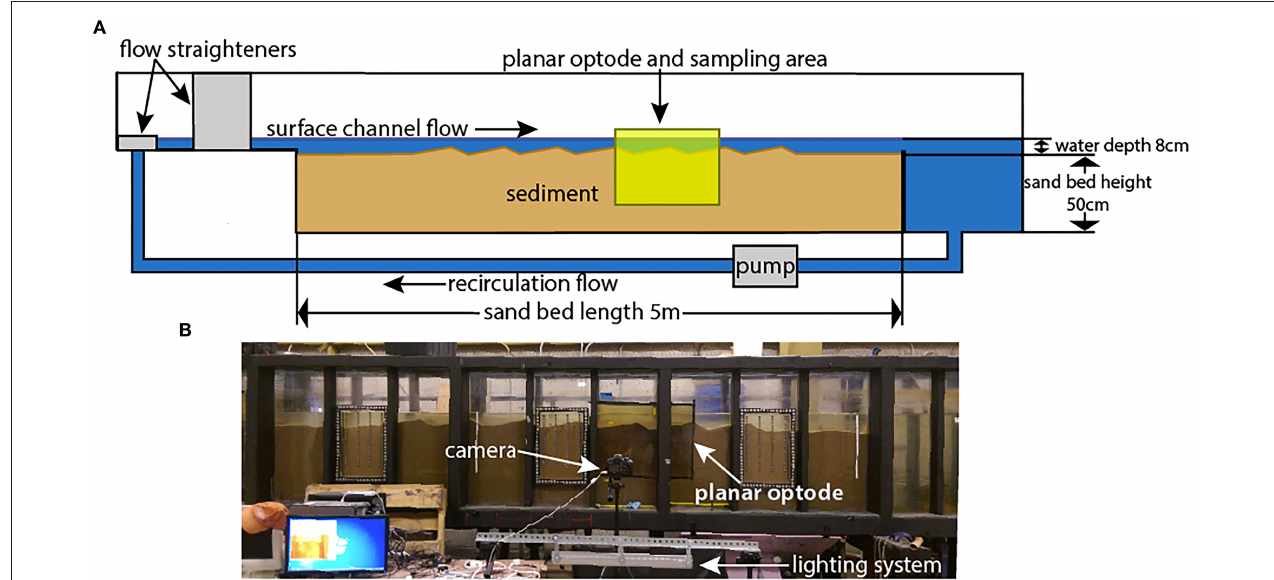
FIGURE 1 | Experimental flume photos and diagram. (A) is a schematic diagram of the flume, showing the direction of flow, position of the planar optode, and position of the sand bed with dune bedforms. The samples were taken from the area covered by the planar optode. (B) is a photo of the operating section of the flume along with the planar optode and its attendant imagine and lighting systems. Figure is modified after Kaufman et al.